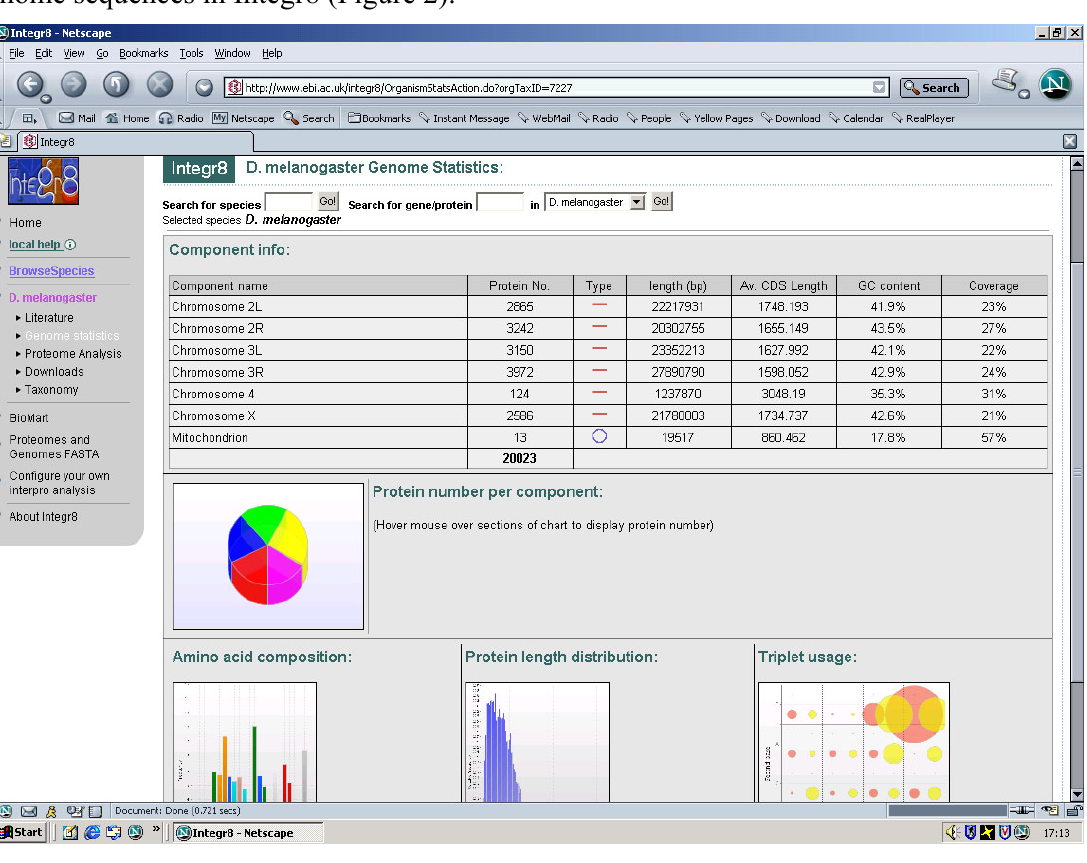
Figure 2: Genome statistics for Drosophila melanogaster. (Average CDS length, GC content and gene coverage are calculated by processing EMBL entries representing components of fully sequenced